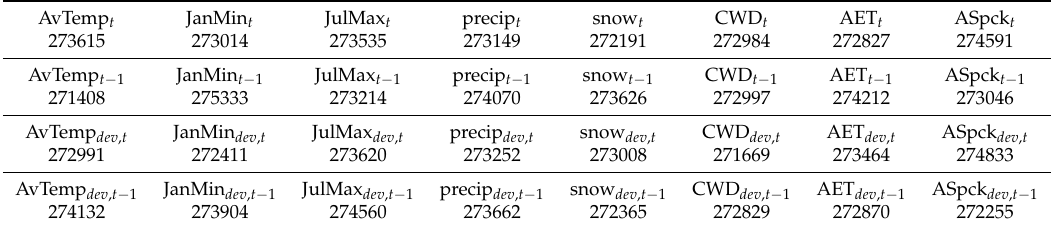
Table A2. DIC for models including each climate variables separately.